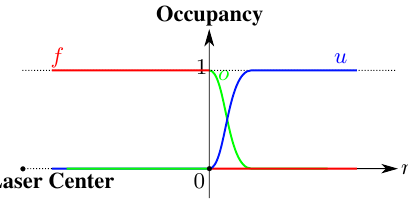
Figure 1. Occupancy in ray direction